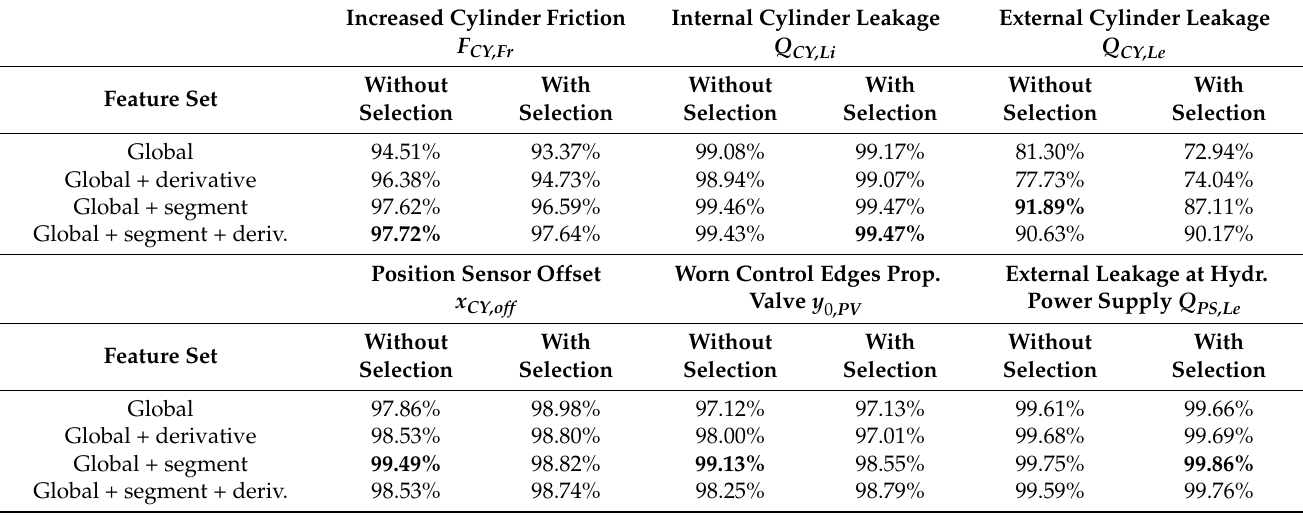
Table 4. Classification accuracies obtained with the best model structure on the held-out test set with and without feature selection, for different feature sets and for different faults. Best results for each fault are highlighted in bold.